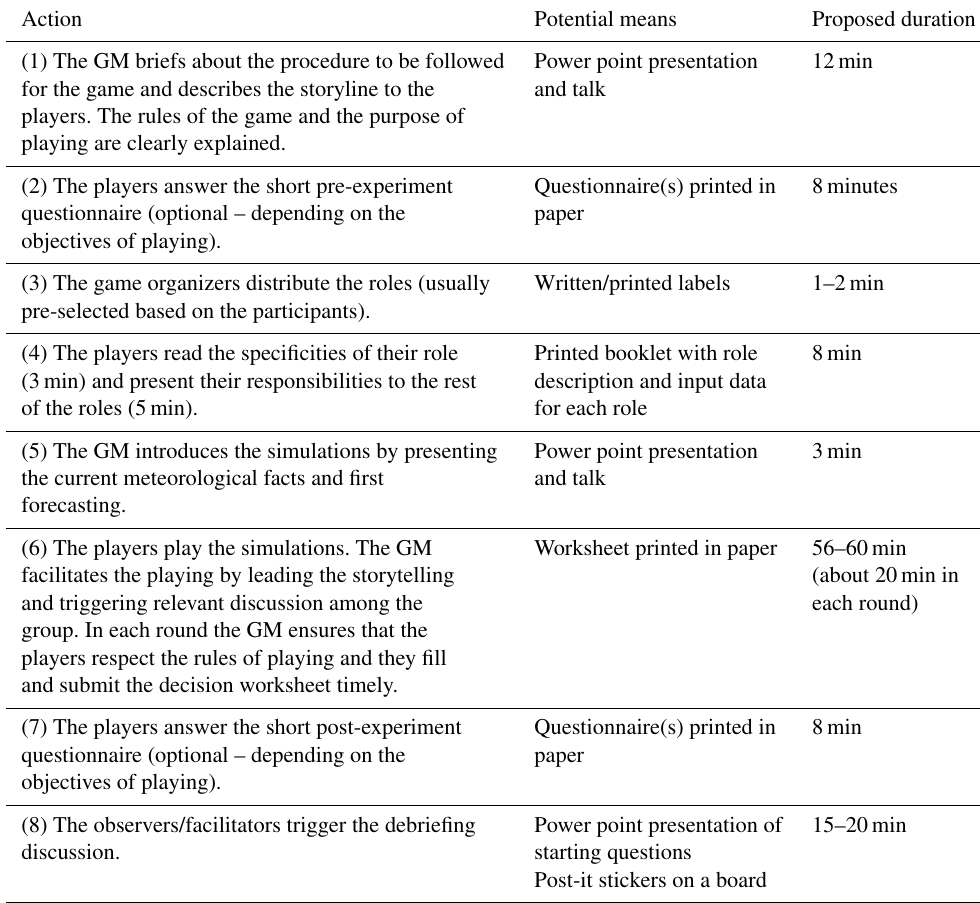
Table 2. Progressive steps of ANYCaRE experiment. The proposed durations suggest an experiment that lasts up to 2h.